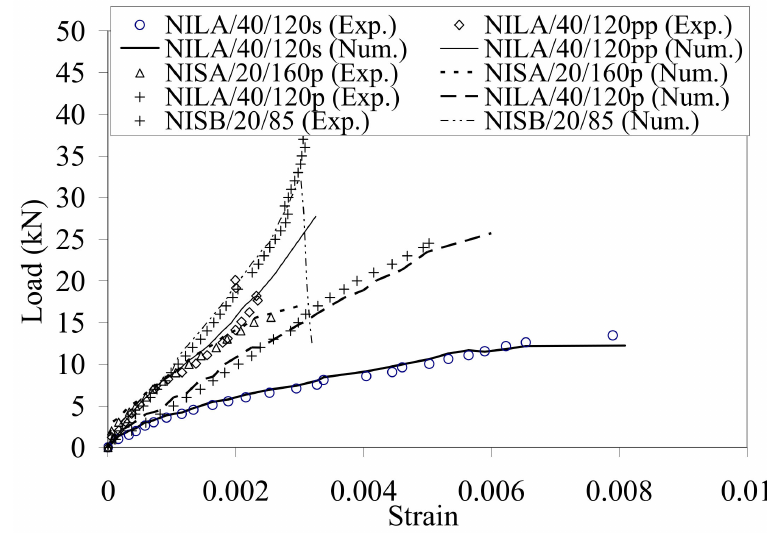
Figure 13. Load–strain profiles in the NSM strips for selected five specimens.